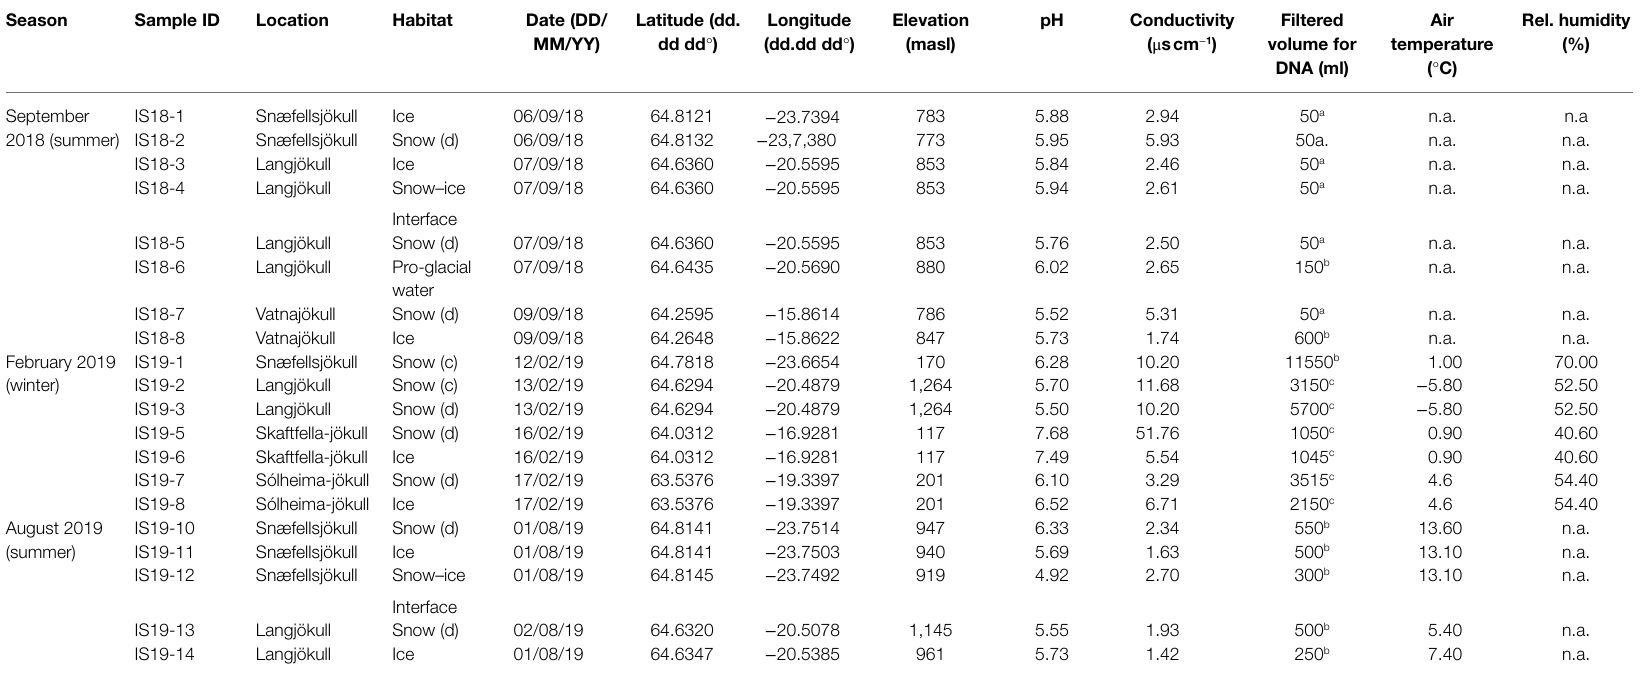
TABLE 1 | Overview of samples, locations, habitats, coordinates, and field measurements.